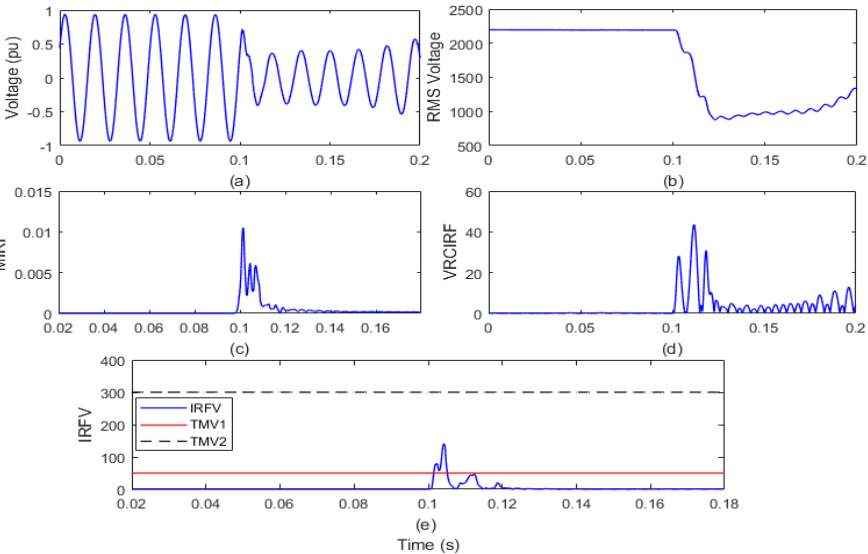
Figure 5. Islanding event in the presence of wind power generation ( a ) voltage signal ( b ) root means square value of voltage ( c ) median-based IRF ( d ) rate of change in voltage-based IRF ( e ) islanding recognition factor based on voltage.